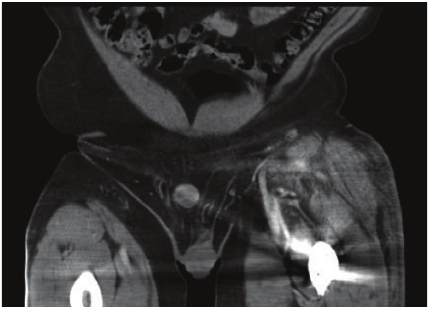
Figure 6: Contrast CT of the left lower extremity showing a suspected pseudoaneurysm of the left profunda femoris